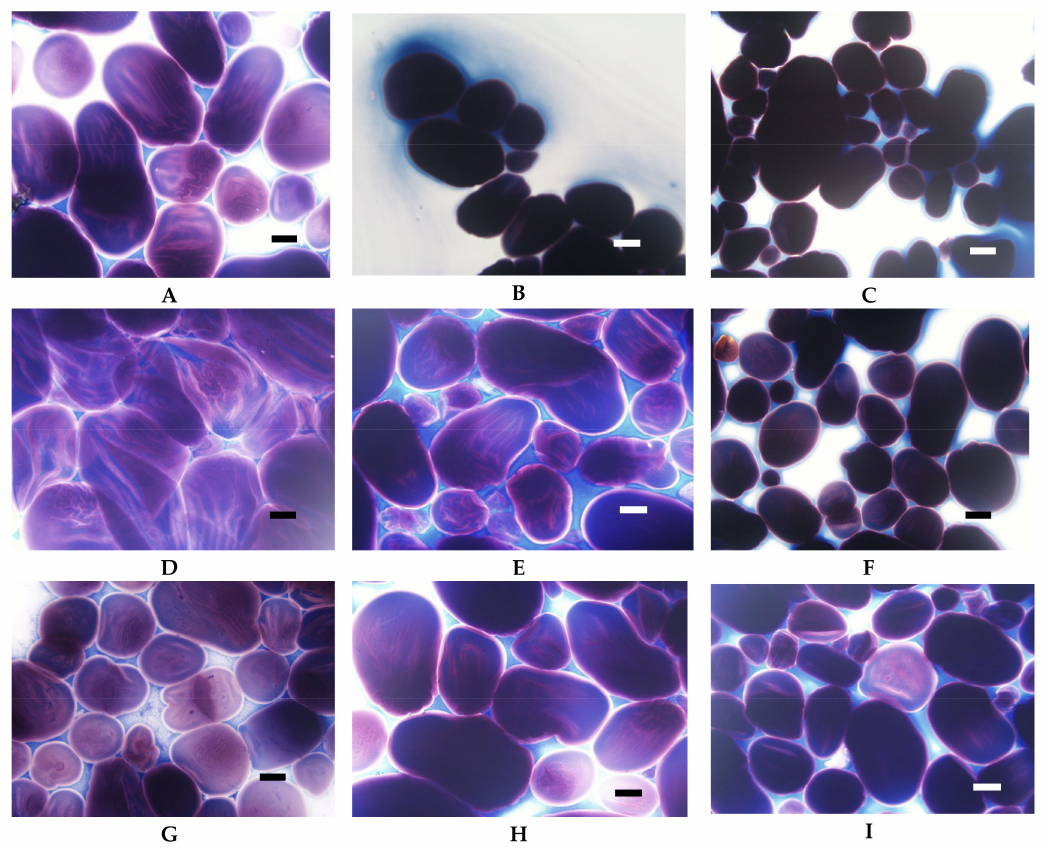
Figure 9. LM micrographs (20 × ) of distarch phosphates of potato origin with di ff erent degrees of crosslinking (L–low, M–medium, H-high) incubated in di ff erent conditions: ( A ) L, 90 ◦ C, pH = 5.5; ( B ) M, 90 ◦ C, pH = 5.5, ( C ) H, 90 ◦ C pH = 5.5; ( D ) L, 123 ◦ C, pH = 5.5; ( E ) M, 123 ◦ C, pH = 5.5, ( F ) H, 123 ◦ C, pH = 5.5; ( G ) L, 90 ◦ C, pH = 3.5; ( H ) M, 90 ◦ C, pH = 3.5, ( I ) H, 90 ◦ C pH = 3.5 (Bar-20 µ